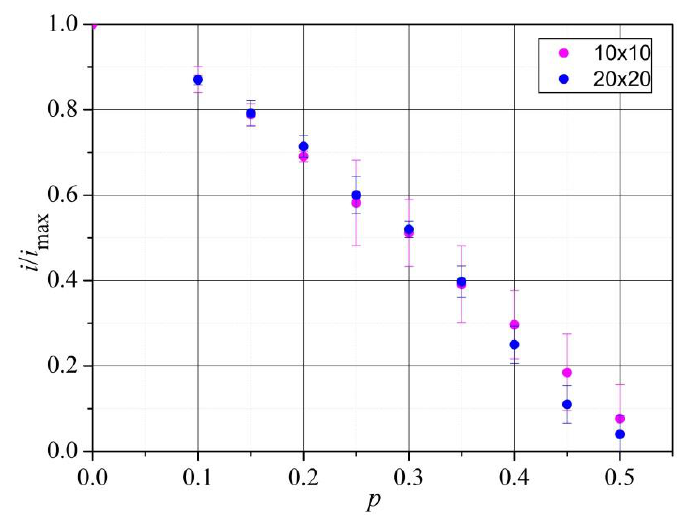
Figure 7. The dependencies of the current intensity as a function of p for two models about mesh sizes 10 × 10 and 20 × 20.